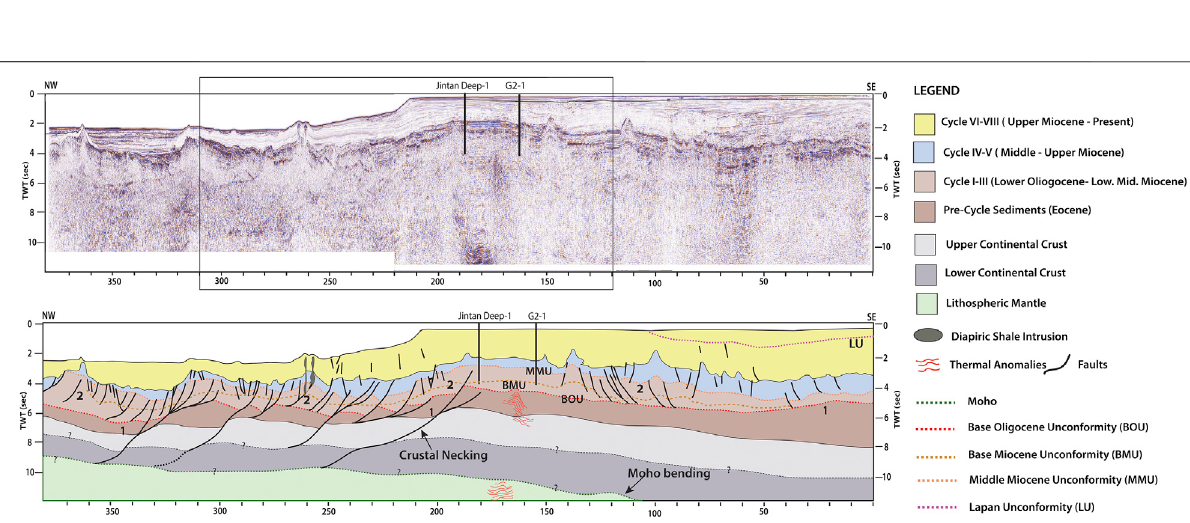
Frontiers in Earth Science |